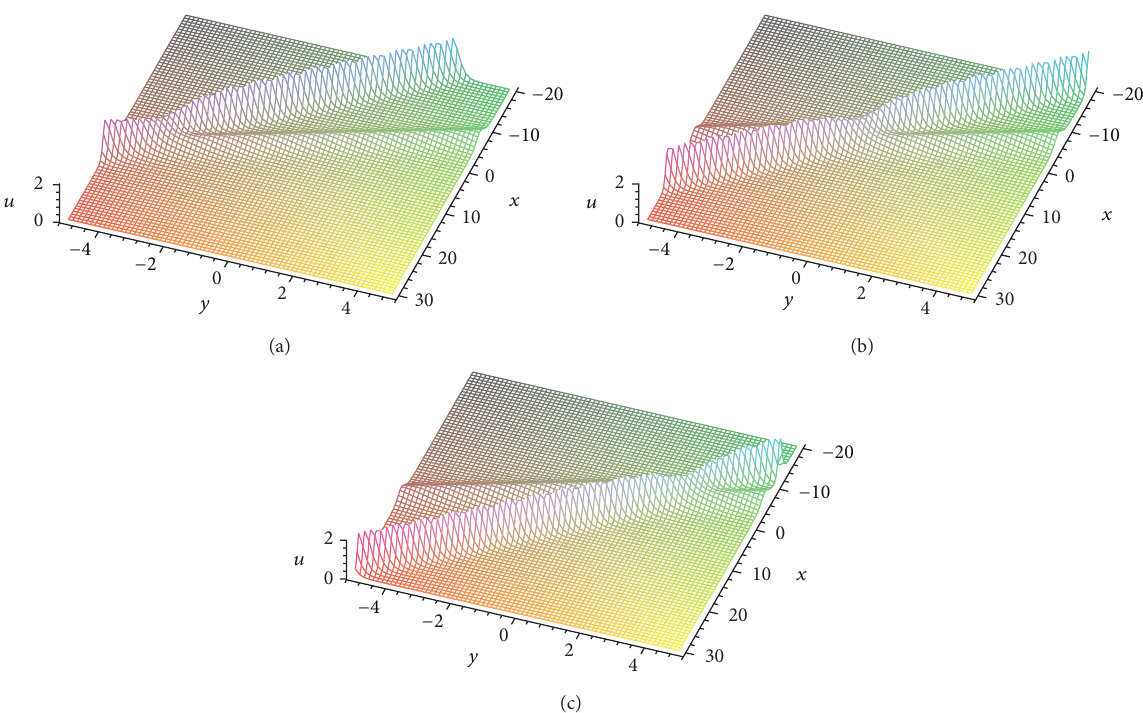
Figure 2: Two-soliton solution via solution (33) with 𝑎 9 = 0.01 , 𝑘 1 = 1 , 𝑘 2 = 2 , 𝑙 1 = 2 , 𝑙 2 = 8 , 𝑐 0 = 1 , 𝑐 1 = 0.02 , 𝑎 1 = 0.2 , and 𝜉 1 = 𝜉 2 = 0 . (a) 𝑡 = −2 ; (b) 𝑡 = 0 ; (c) 𝑡 = 2 .